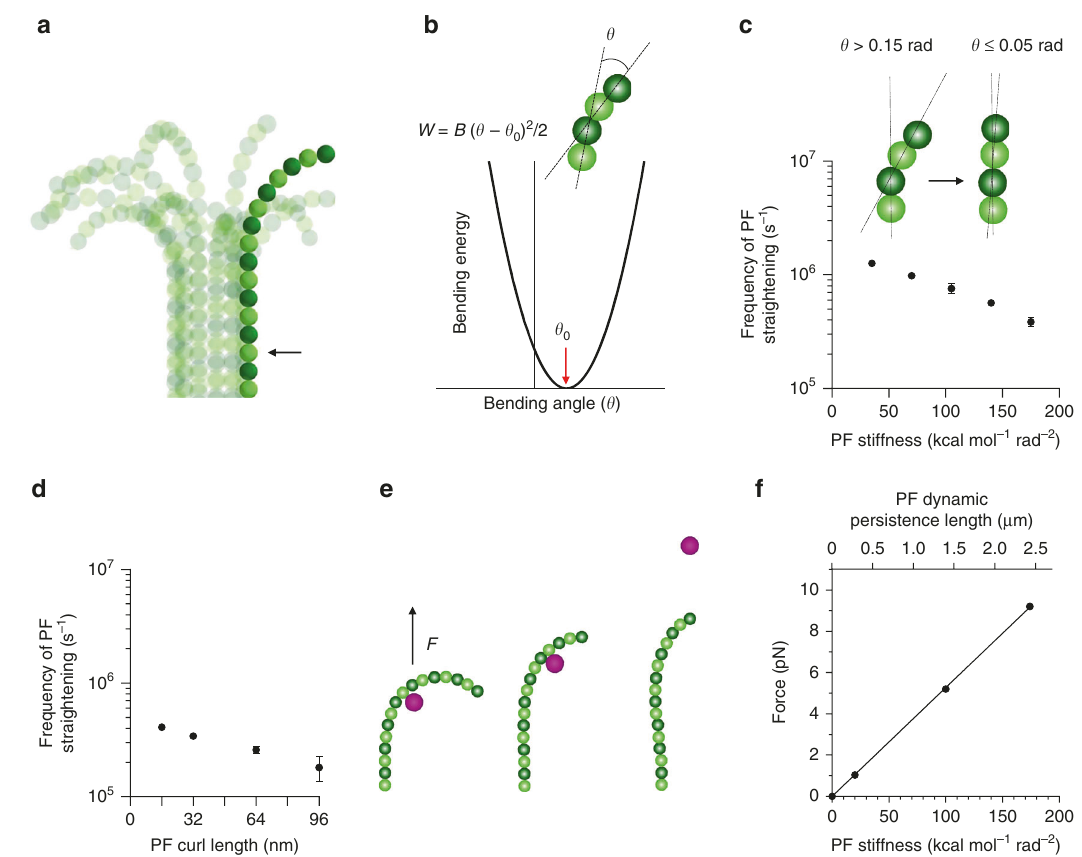
Fig. 1 Brownian dynamics analysis of the properties of isolated tubulin PFs. a Visualization of a single PF. Darker and lighter spheres depict β - and α - tubulins, respectively. For illustration, tubulins in other PFs of the MT, which were not part of this simulation, are shown as semi-transparent spheres. The bottom tubulin dimer of the simulated PF is fi xed in place, while the other tubulins experience Brownian fl uctuations. b Potential energy of PF bending, described with the formula above the graph. c Predicted dependence of the frequency of PF straightening by thermal fl uctuations on the PF bending stiffness. Straightening frequency is calculated as the number of passages per second from curved ( θ > 0.15 rad) to straight ( θ ≤ 0.05 rad) con fi gurations at the lowest nonrestrained tubulin monomer in the PF (black arrow in a ). Data represent mean ± s.d. from three repeats of each simulation. Source data are provided as a Source Data fi le. d Predicted dependence of the frequency of PF straightening by thermal fl uctuations on the length of the PF. The frequency is scored as in panel c . Simulations were carried out with PF bending stiffness of 174 kcal mol − 1 rad − 2 . Data represent mean ± s.d. from three repeats of each simulation. Source data are provided as a Source Data fi le. e A single PF experiencing an extensive force. In this case, the PF cannot withstand force, F , with which the purple sphere is dragged upwards. f Dependence of the force a PF can withstand, as a function of the PF bending stiffness, expressed in two ways on the two X